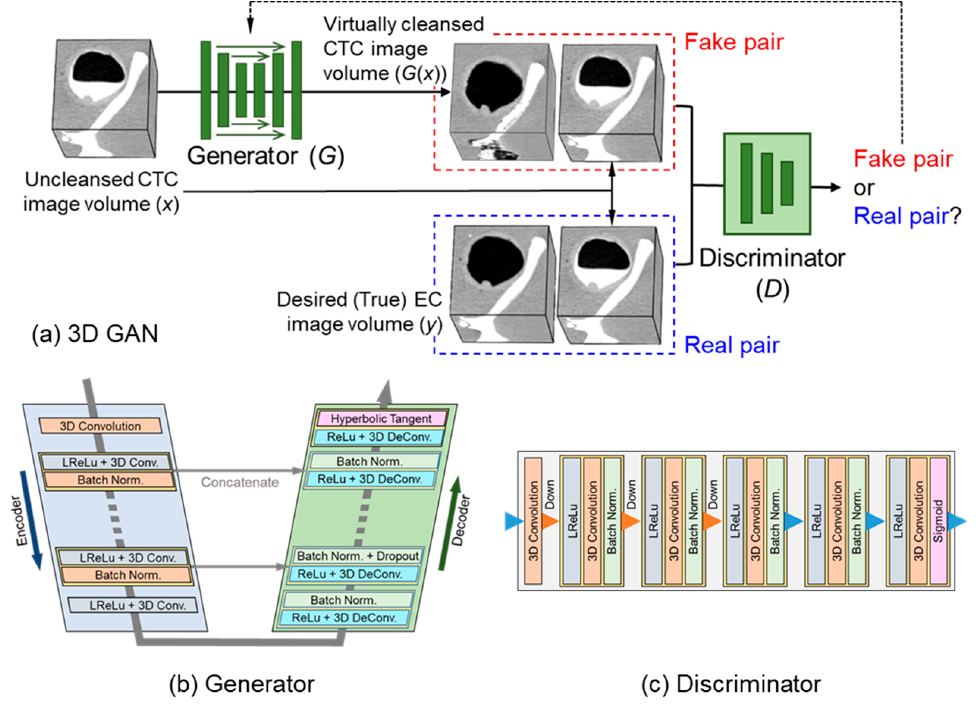
Figure 1. ( a ) Overview of the training process in the 3D GAN. ( b ) Architecture of the generator in the 3D GAN. ( c ) Architecture of the discriminator in the 3D GAN.